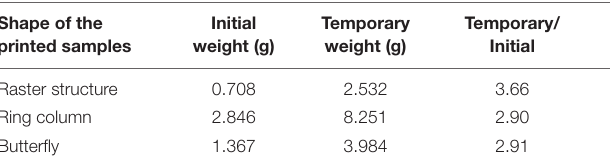
TABLE 1 | Weight change of the printed structures before and after absorbing water. Shape of the printed samples